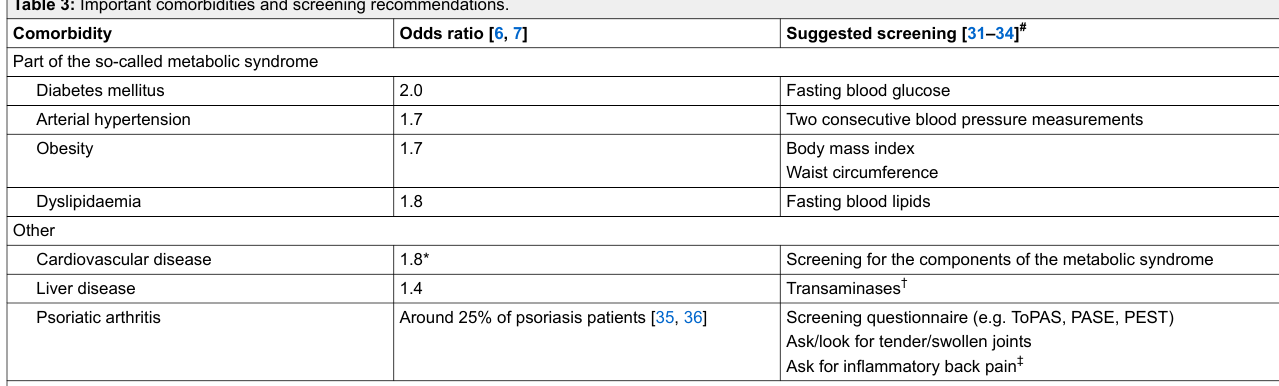
Table 3: Important comorbidities and screening